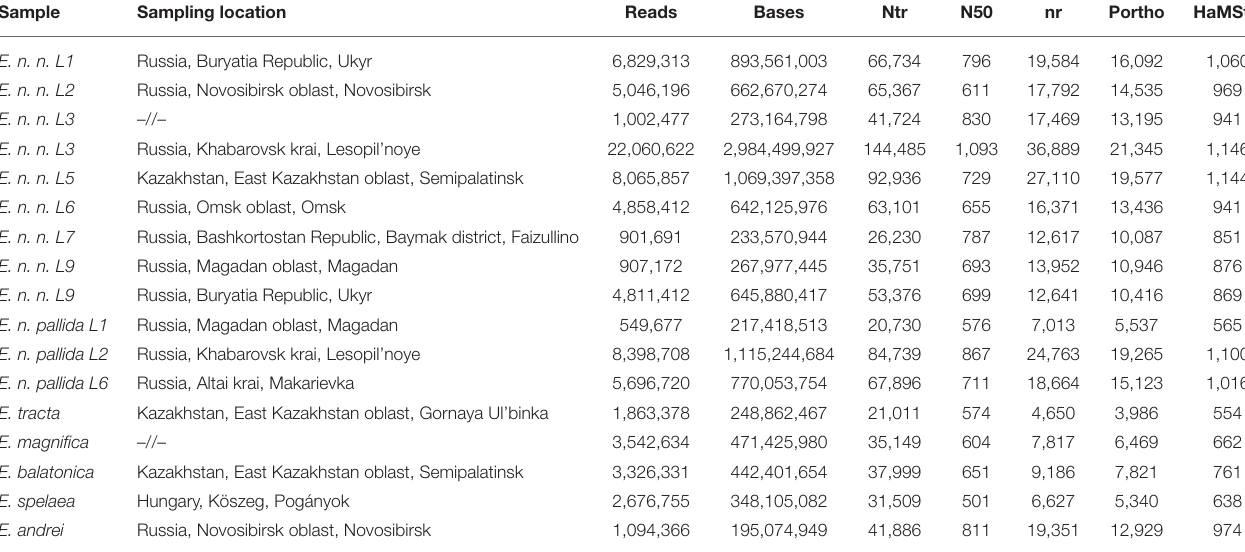
TABLE 1 | Samples taken for transcriptomic analysis. Sample Sampling location Reads Bases Ntr